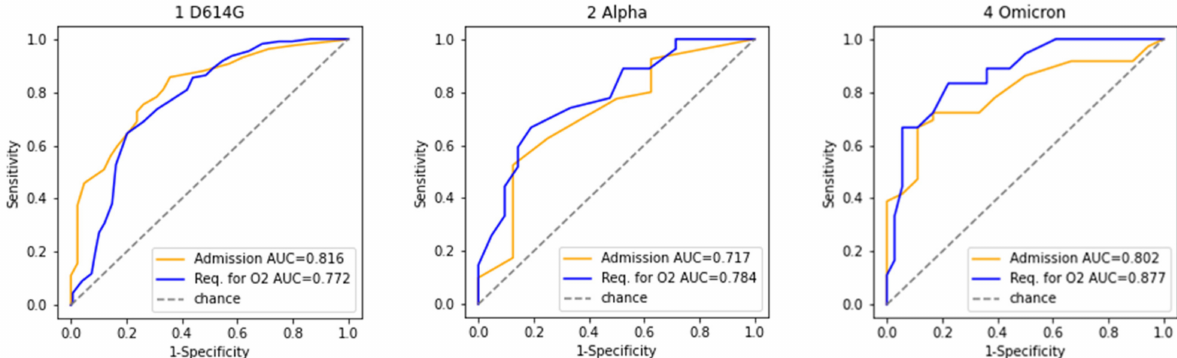
Figure 3. Performance of the CORONET model in different waves. CORONET scores were calculated for 258, 48, and 54 patients who were included from wave 1. D614G, 2. Alpha, and wave 4. Omicron. AUC = area under the curve calculated for admission and requirement for oxygen